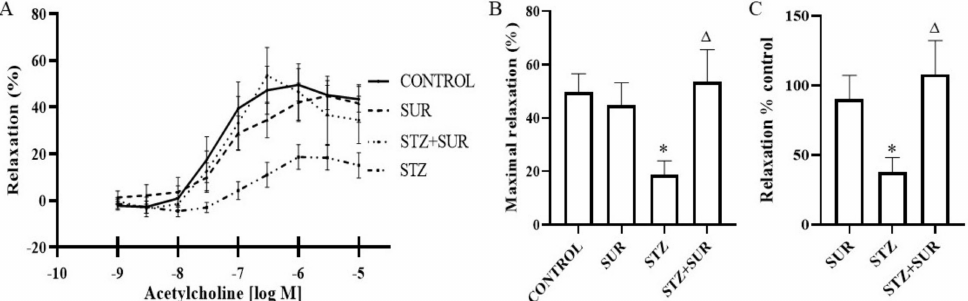
Figure 8. Relaxation effect of acetylcholine on the interlobar artery isolated from non-diabetic and diabetic rats treated with suramin. ( A ) The concentration-dependent effect of acetylcholine on